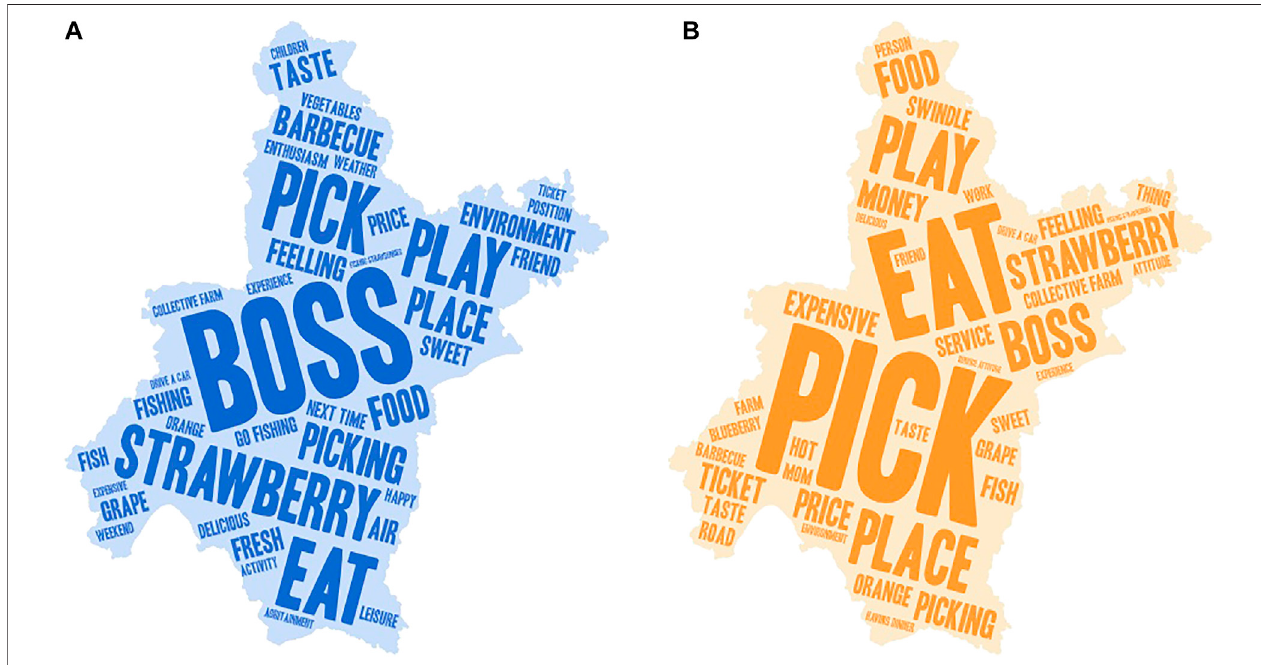
FIGURE 6 | Keyword cloud of tourist comments on leisure agriculture in Wuhan: (A) Negative comments; (B) Positive comments.